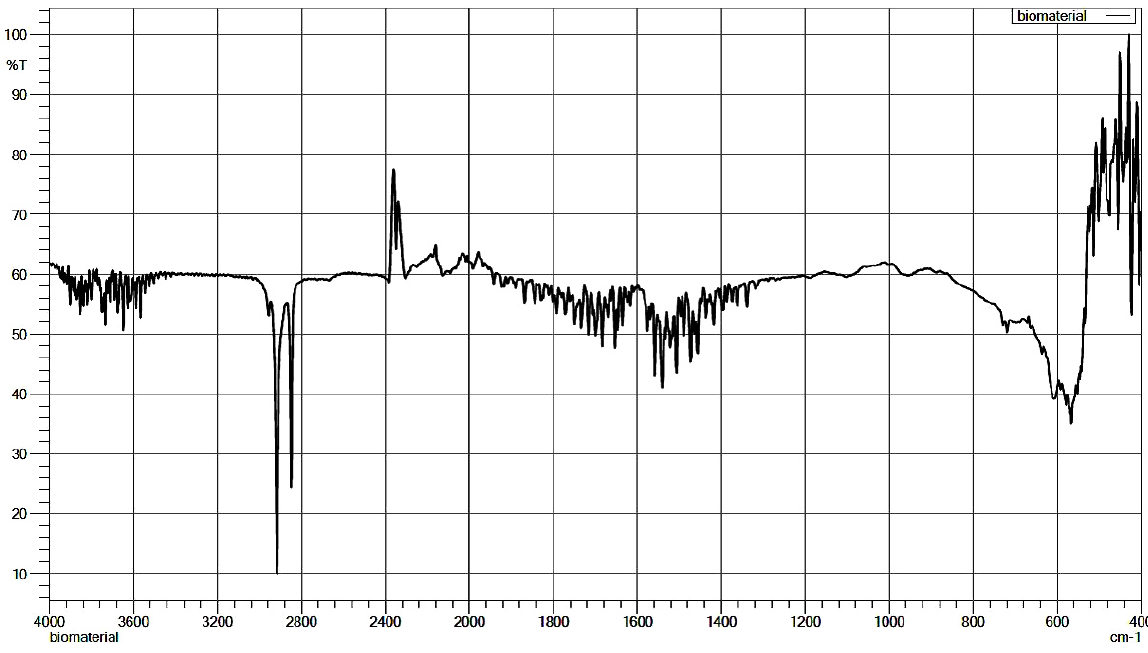
Figure 2. FT – IR ATR analysis of porous corundum biomaterial. Figure 2. FT–IR ATR analysis of porous corundum